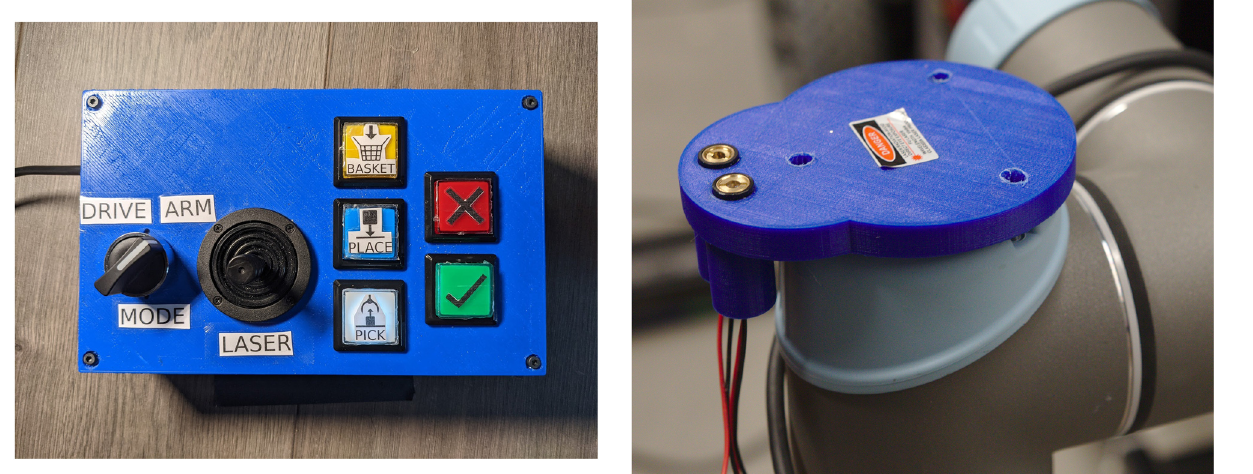
Figure 9: Laser device mounted to the end e ff ector of the